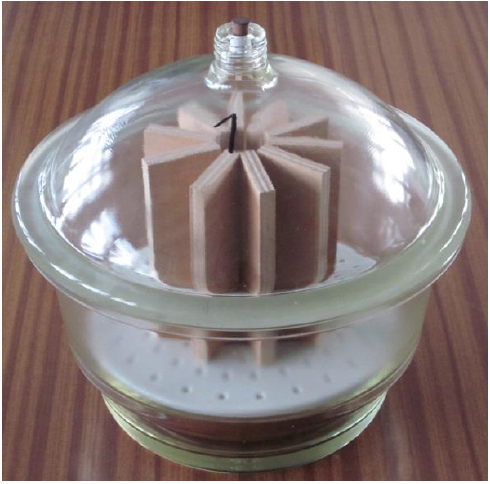
Figure 1. Plywood samples in the glass desiccator.